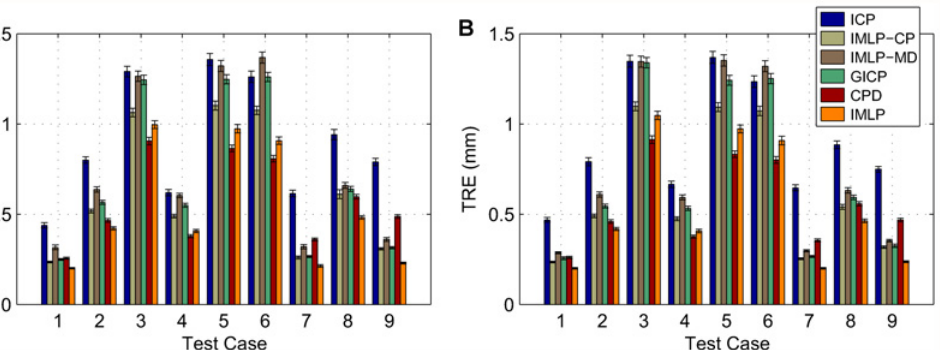
Fig 5. Registration errors for registering a point-cloud target shape. (Experiment 4). Source shapes were randomly generated from a mesh model of a human hip (Fig. 1A), misaligned by (A): [15, 30] mm / degrees and (B): [30, 60] mm / degrees, and registered back to a point-cloud representation of the mesh. The test cases represent different noise models used to generate noise on the source shape (Table 4). For each test case, 300 randomized trials were conducted, with successful registrations being used to compute an average target registration error (TRE). The error bars provide approximate standard deviations of the reported average TRE values. The proposed IMLP algorithm was evaluated relative to standard ICP [1], GICP [11], and CPD [20], as well as relative to near-comparisons of GTLS-ICP [10] and A-ICP [12] using the two variants IMLP-CP and IMLP-MD, which modify IMLP ’ s most-likely match criteria to that of closest-point and Mahalanobis-distance matching,